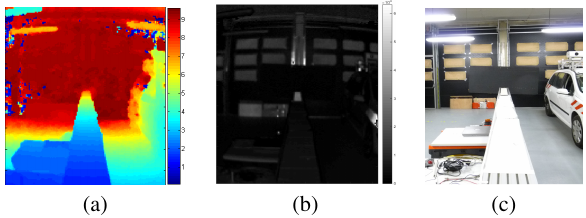
Figure 2. Sample acquisition of an indoor scene by the SR4500 ToF camera. (a) Distance matrix (b) amplitude matrix, in the close infrared (c) Photograph of the scene taken by an external